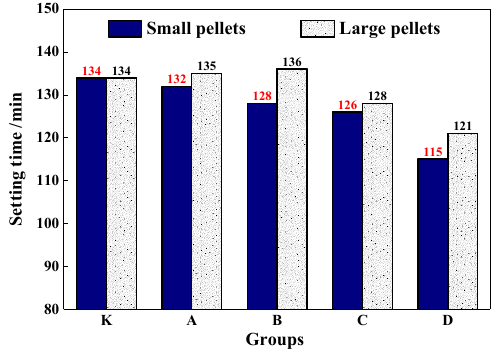
Figure 13. Setting time of mortar mixed with pellets.